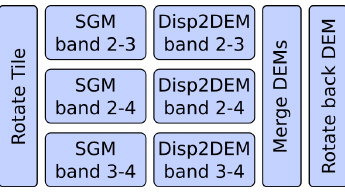
Figure 5. Workflow of proposed method